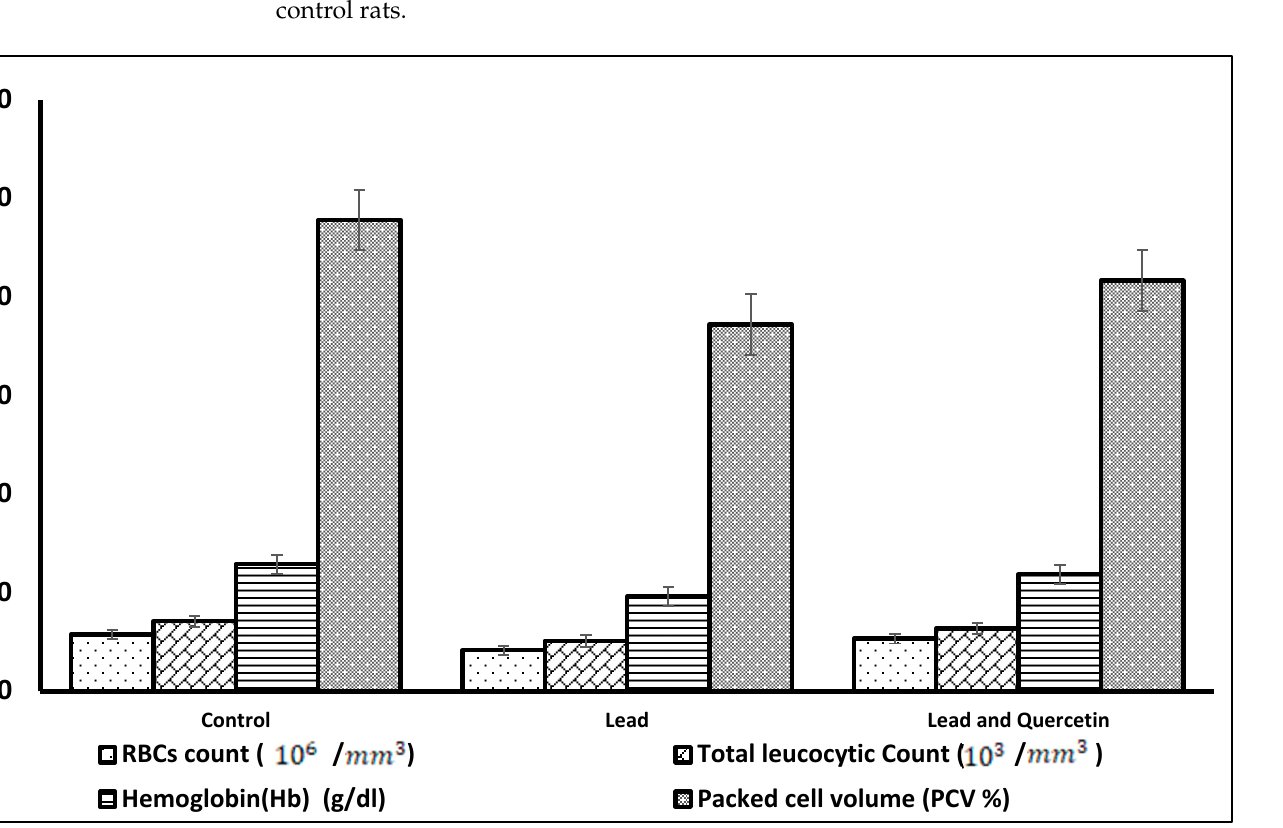
cantly different from lead group.